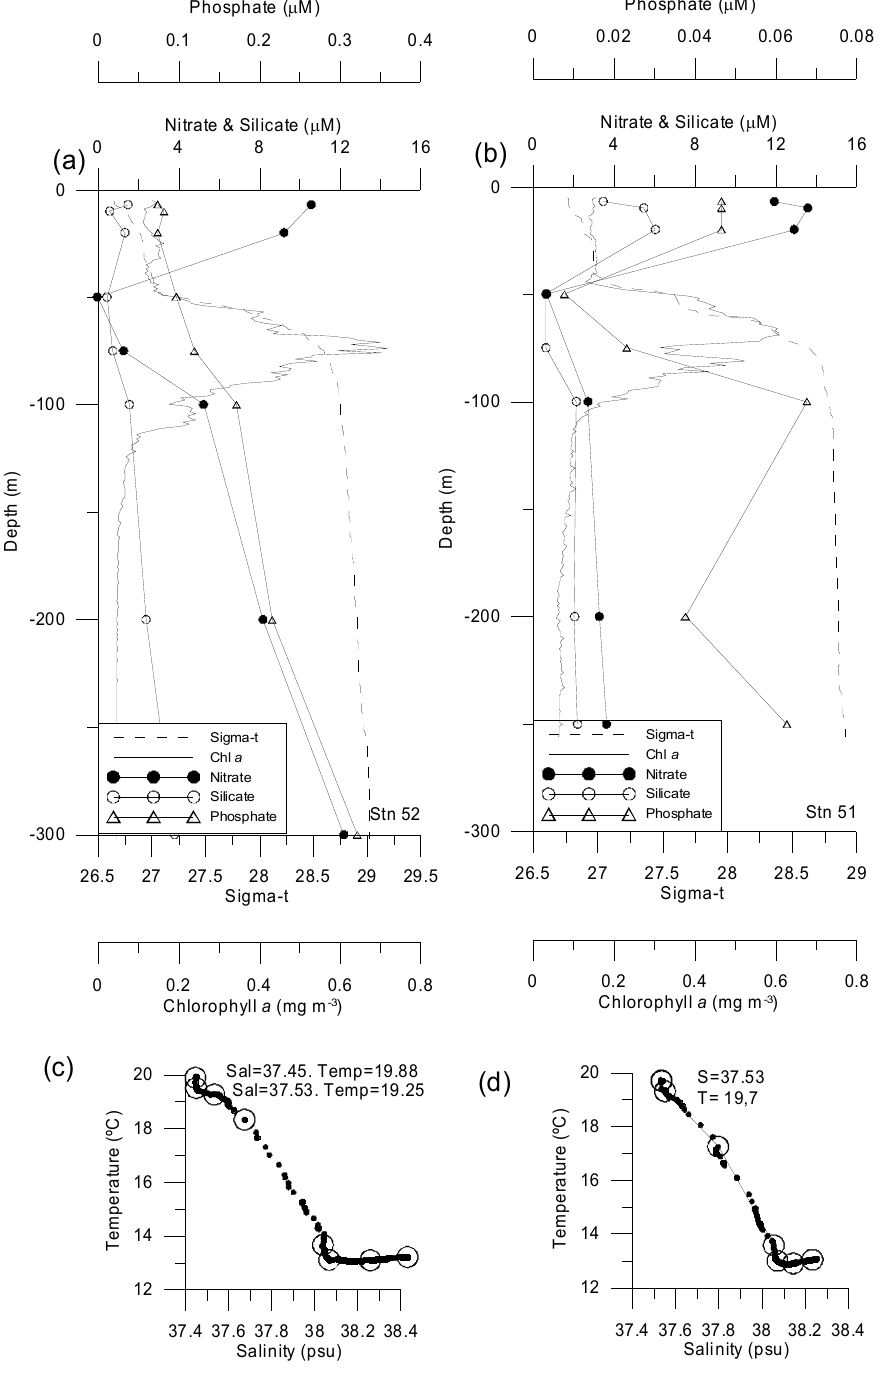
Figure 7. Vertical profile of density (sigma ‐ t), and Chl a and nutrient concentrations ( a ) at Stn 52, and ( b ) at Stn 51. Temperature–salinity (TS) diagrams ( c ) at Stn 52, and ( d ) at Stn 51.